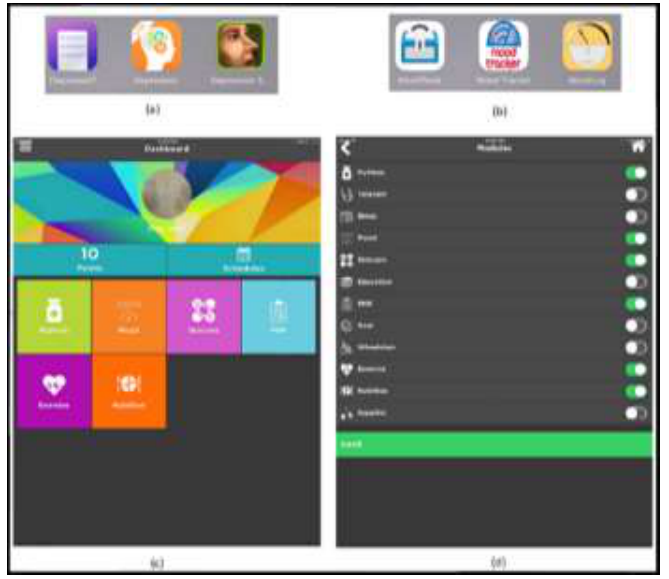
Screenshots of iMHere 2.0 Used in the Study